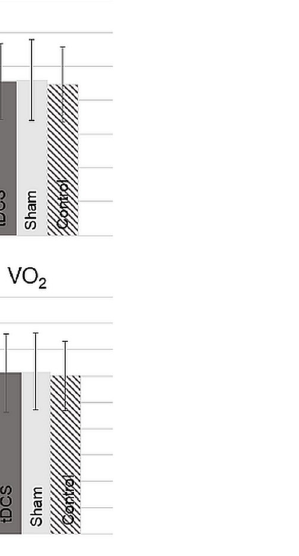
Fig 4. Average time, power output, heart rate, and oxygen consumption (VO 2 ) during the 250-kJ time trial. The dark grey bars represent the a-tDCS condition, the light grey bars represents the sham condition, and the striped bars represents the control condition. The error bars represent the standard deviation. N =